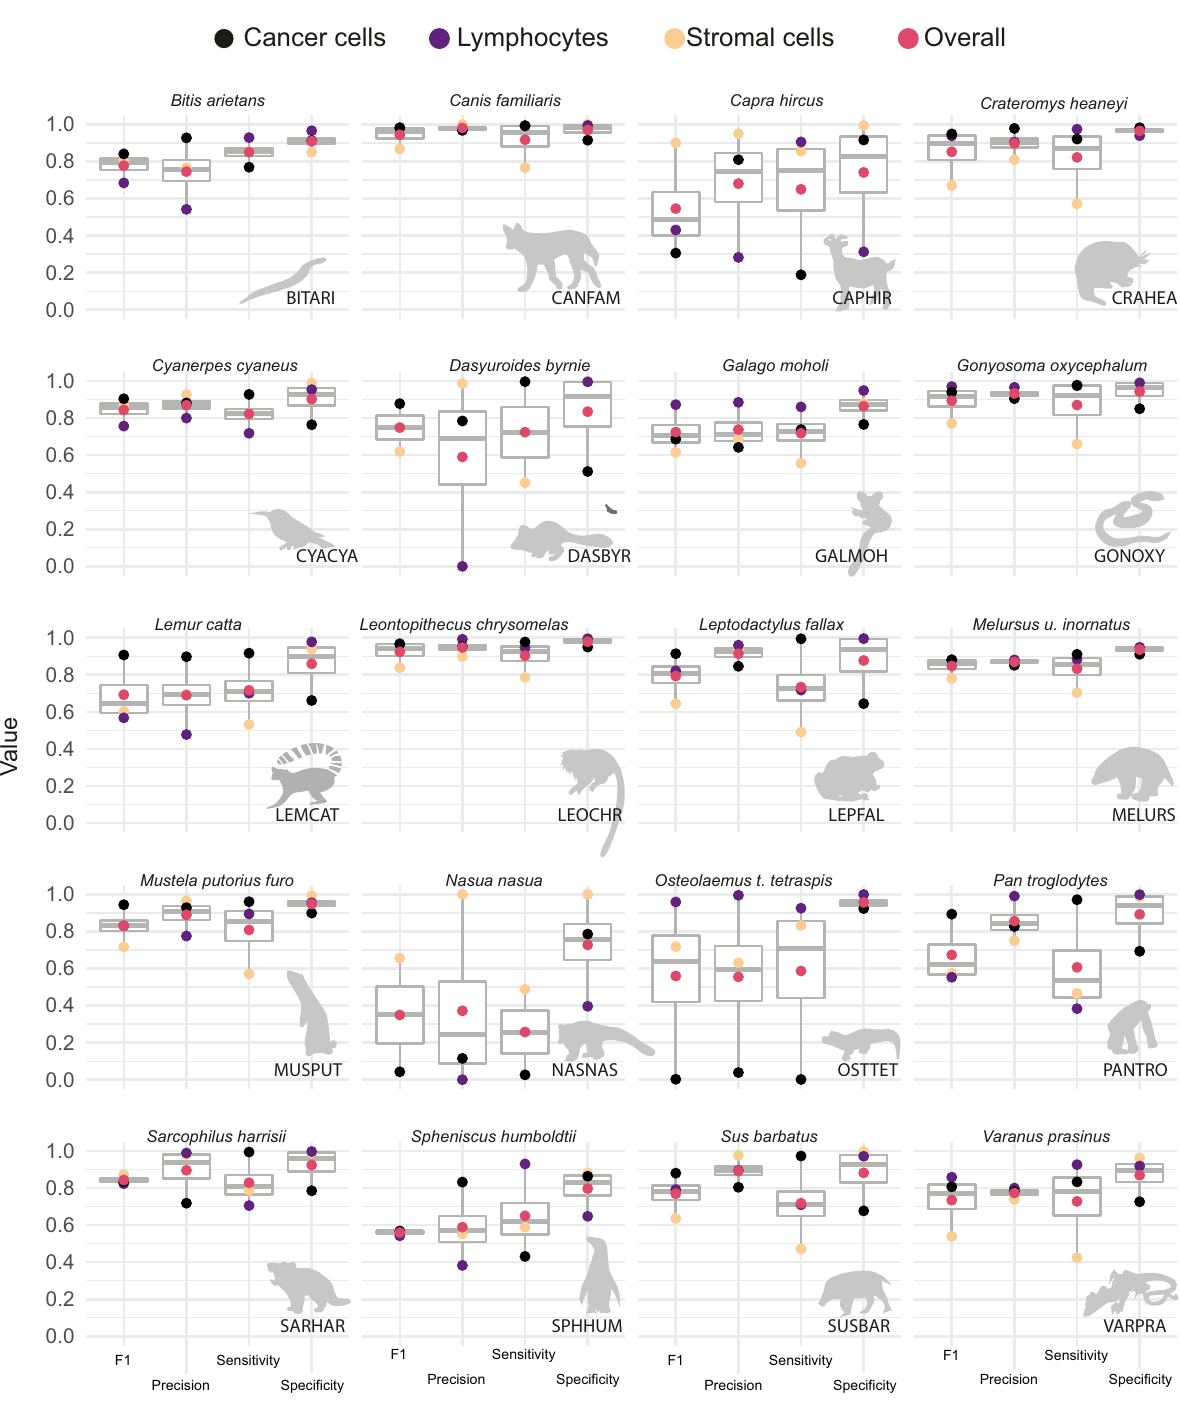
Fig. 3 | AI model prediction performance metrics for 20 species. For each species, four metrics were evaluated, including F1, precision, sensitivity, and speci fi city (as labelled on the x-axis) for the prediction accuracy of cancer, lymphocytes, and stromal cells, as well as their average shown as ‘ overall ’ (as denoted with colours on the top x-axis). For species codes, see Table 1. For